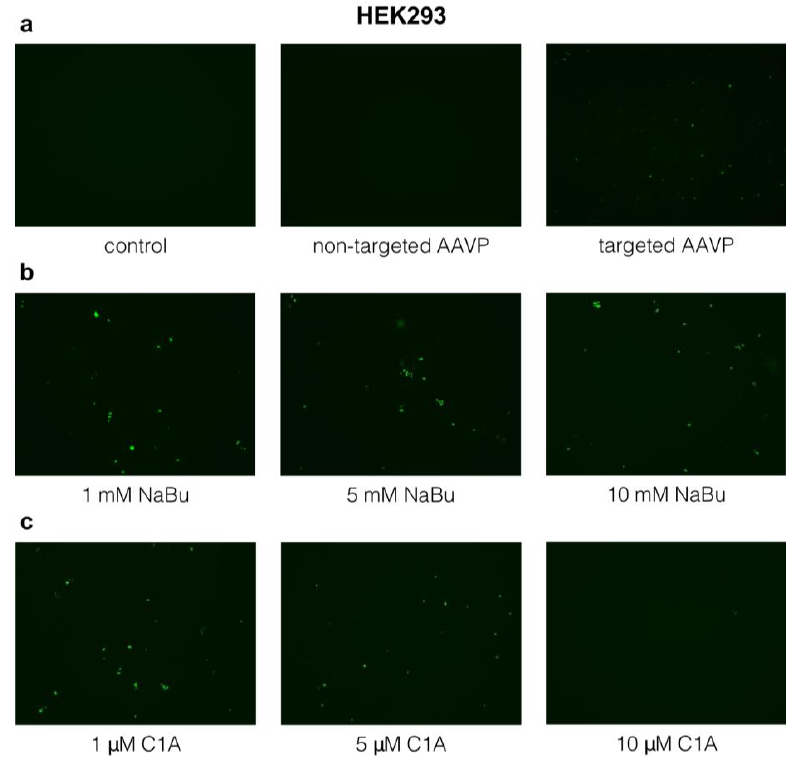
Figure 2. Gene delivery by RGD4C-adeno-associated virus/phage (AAVP) in vitro into HEK293 cells 6 days post vector transduction with and without adjuvants. ( a ) Control (untreated cells) and non-targeted AAVP did not show any green fluorescent protein (GFP) expression, while targeted AAVP (RGD4C-AAVP) showed some transgene expression. ( b ) Sodium butyrate (NaBu)